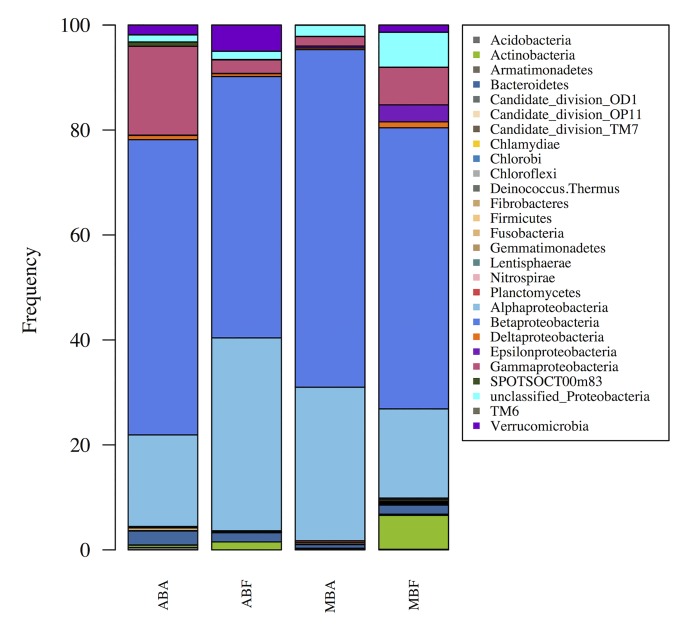
Relative abundance of the phyla and Proteobacteria classes, expressed as the proportion of the average number of reads from each sample after normalization to the smallest sample (n = 3402).(AB) for Anabaena bloom, (MB) for Microcystis bloom and (F) for free living fraction and (A) for the associated fraction.